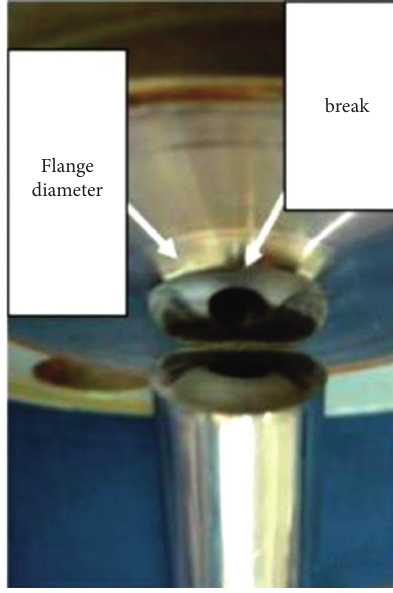
Figure 9: Fracture modes of